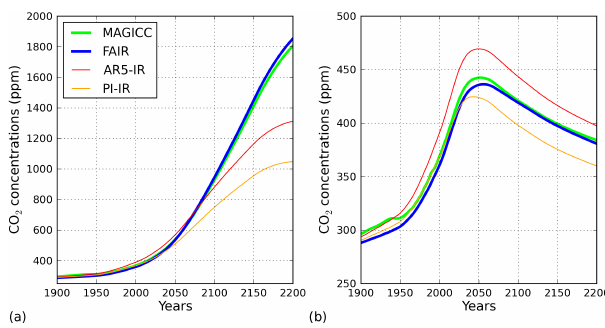
Figure 2. CO 2 concentrations under RCP8.5 (a) and RCP2.6 (b) . FAIR (blue), AR5-IR (red), PI-IR (orange), and MAGICC (green) are shown in both